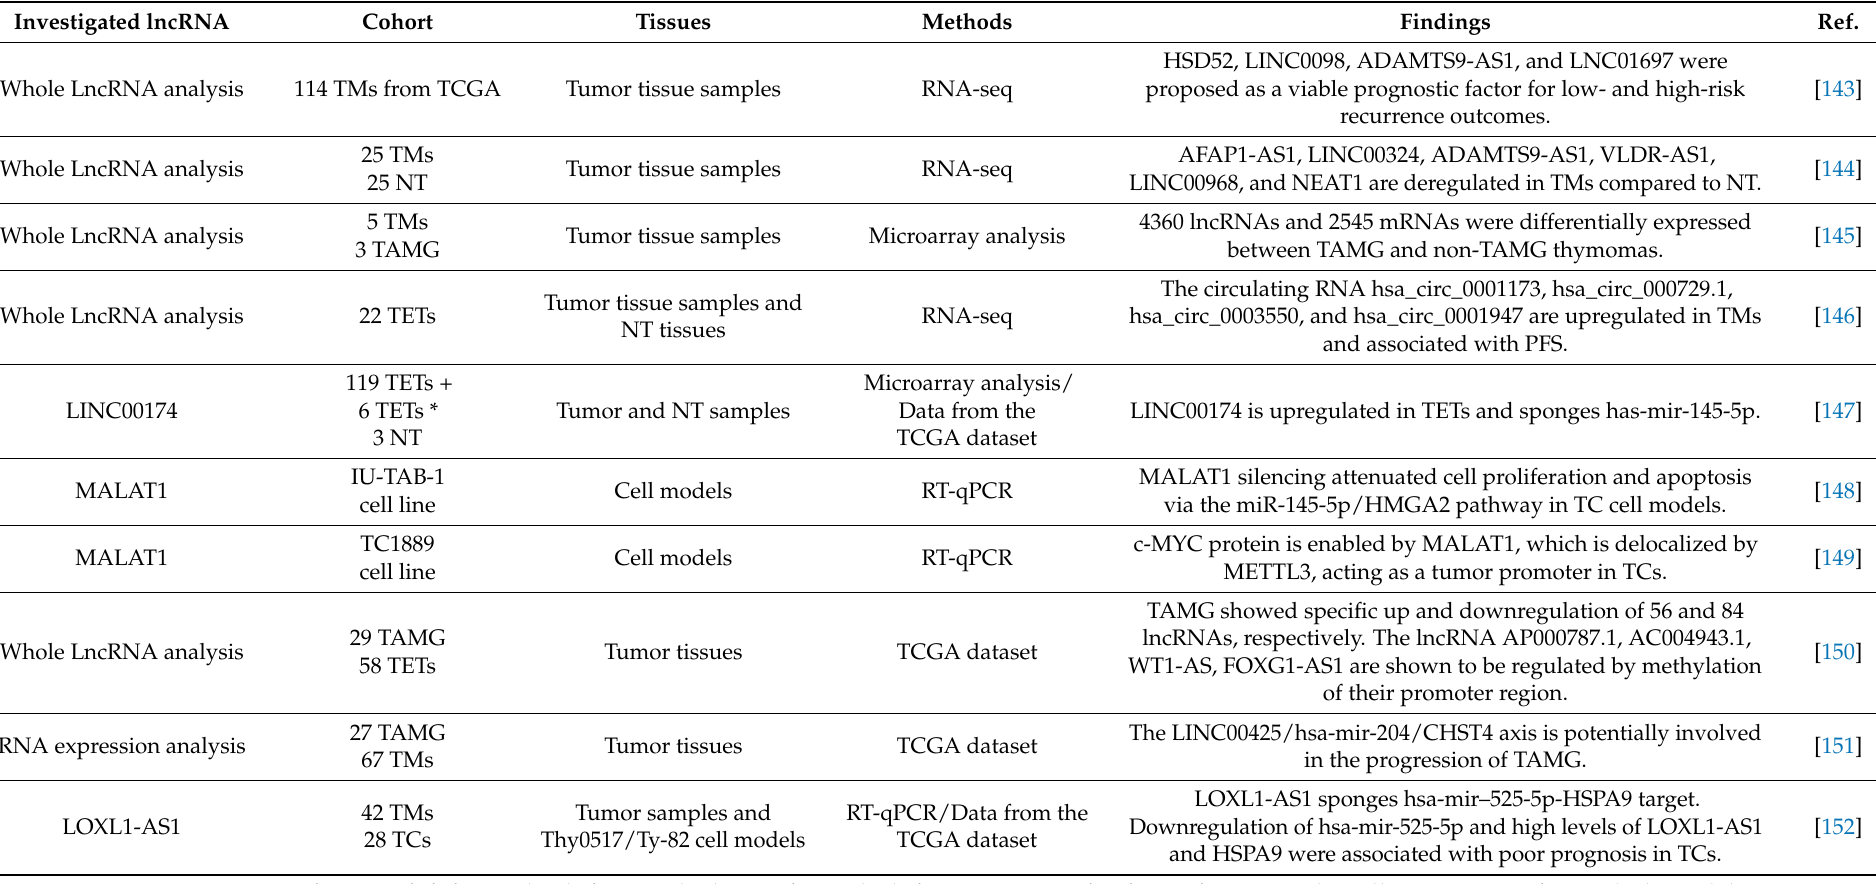
Table 3. Works investigating the long non-coding RNAs in